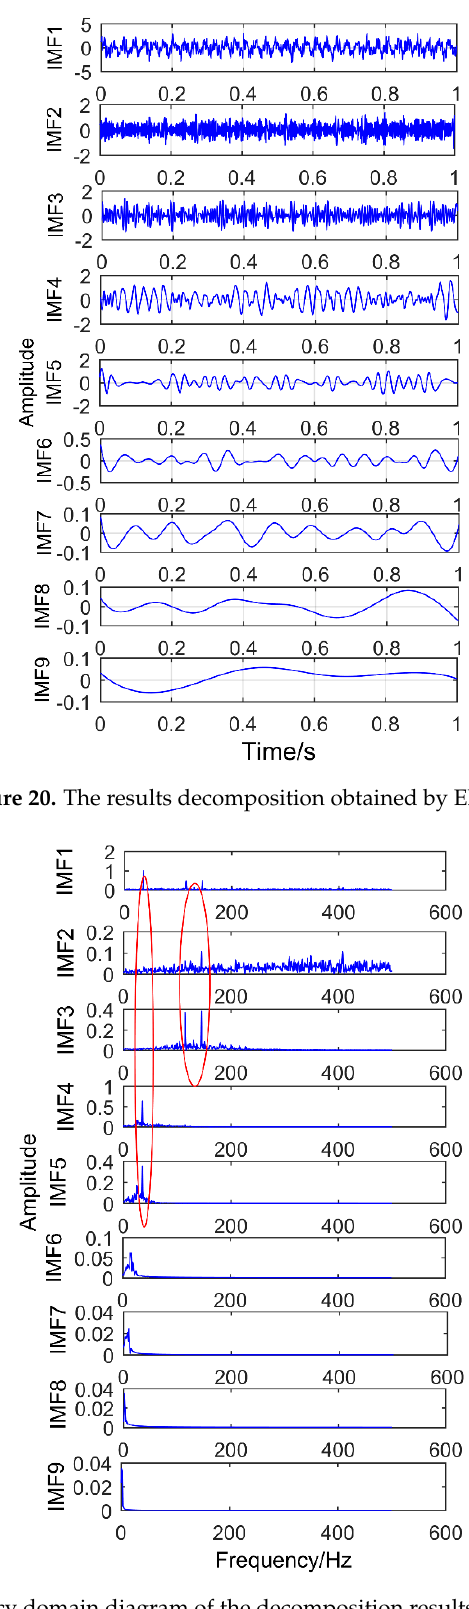
Figure 21. Frequency domain diagram of the decomposition results obtained by EEMD.